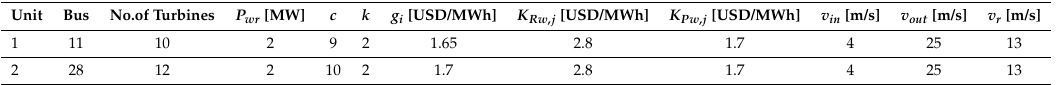
Table A4. Data of wind power plant for IEEE 30-bus Modified (2).